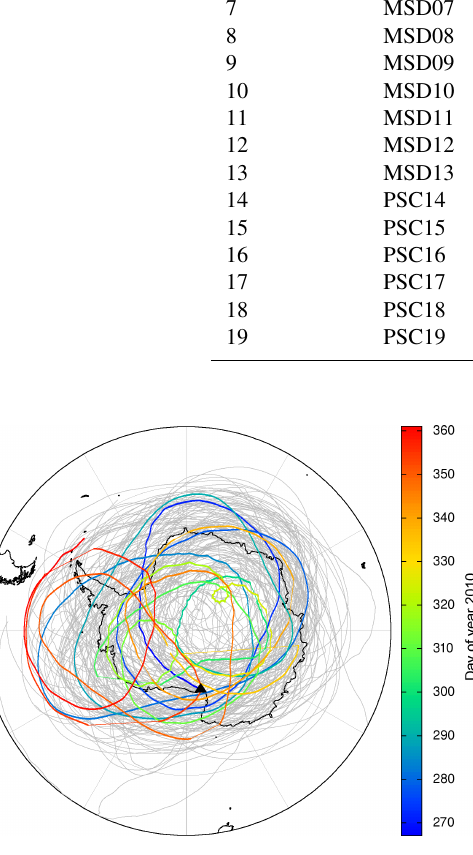
Figure 1. Map of superpressure balloon trajectories (gray curves) during the Concordiasi field campaign in Antarctica in September 2010 to January 2011. The colored curve highlights the trajectory of flight number 4. The black triangle shows the location of McMurdo